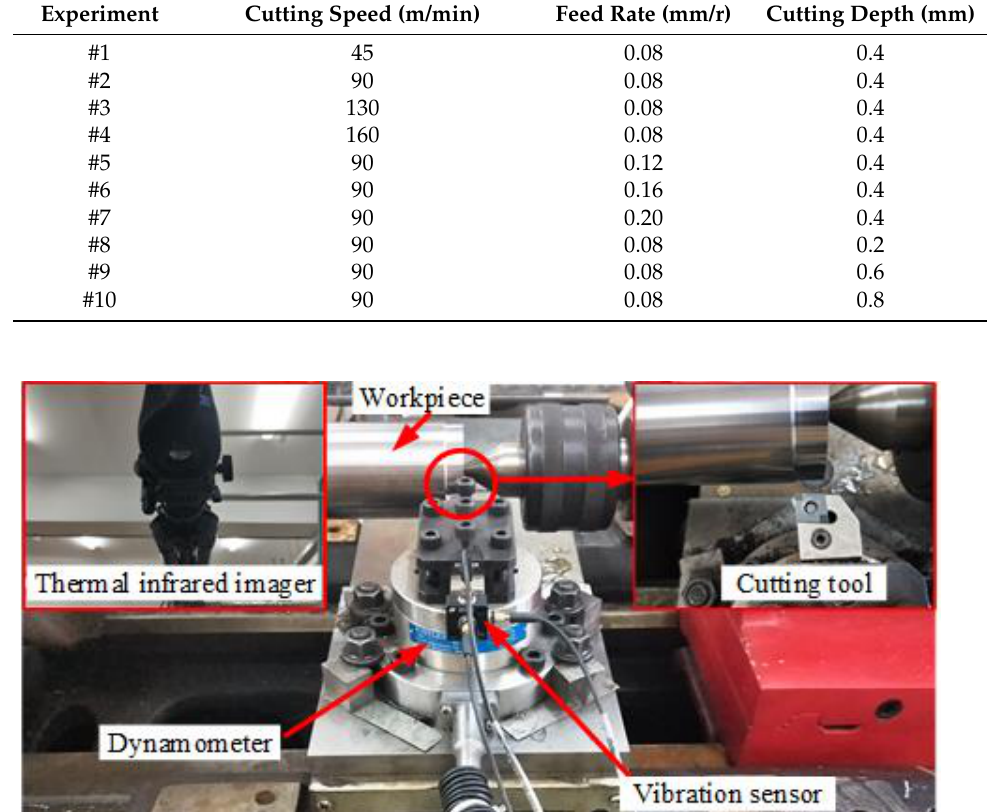
Table 2. Tool geometric parameters.